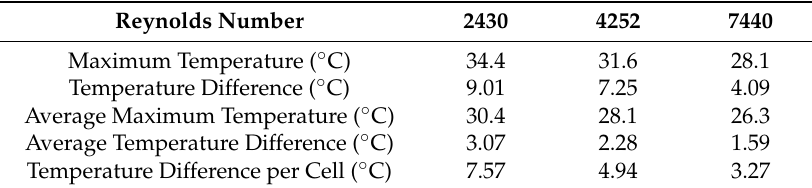
Table 4. Variation of different parameters with increasing Reynolds